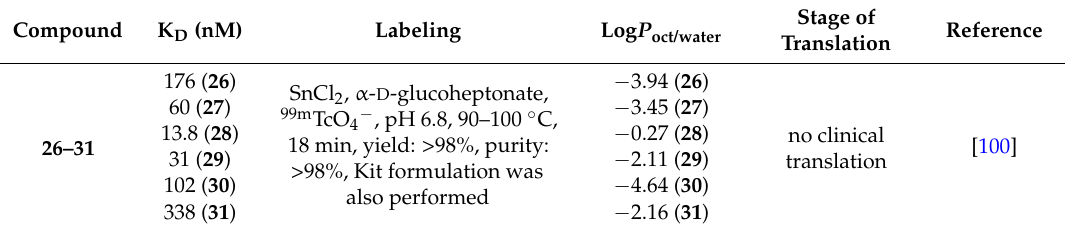
Table 2. Affinity, labeling and lipophilicity data of the 99m Tc-labeled PSMA inhibitors.